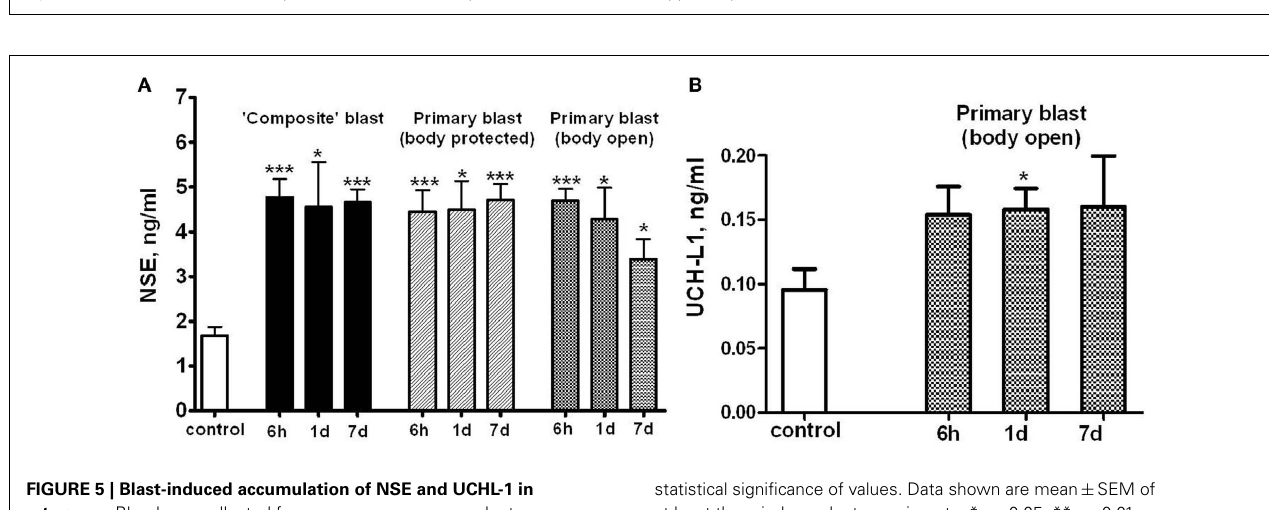
FIGURE 4 | Immunohistochemical analysis of astrocyte and oligodendrocyte markers in hippocampus after blast. Time-dependent GFAP and CNPase expression was studied by IHC on paraffin-embedded 6 μ m brain sections after blast exposure at different set-ups. (A) Naive; (B)